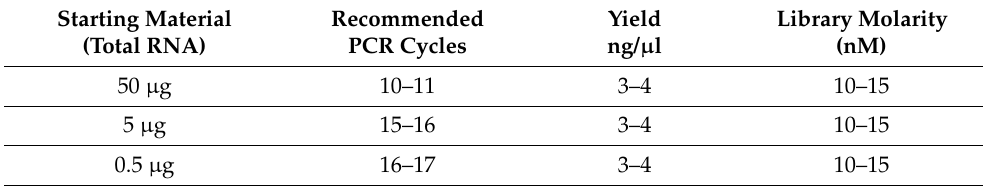
Table 1. Recommended amplification according to the amount of total RNA used as a starting point. After amplification, a library molarity between 10 and 15 nM is expected. This molarity is adequate for following sequencing